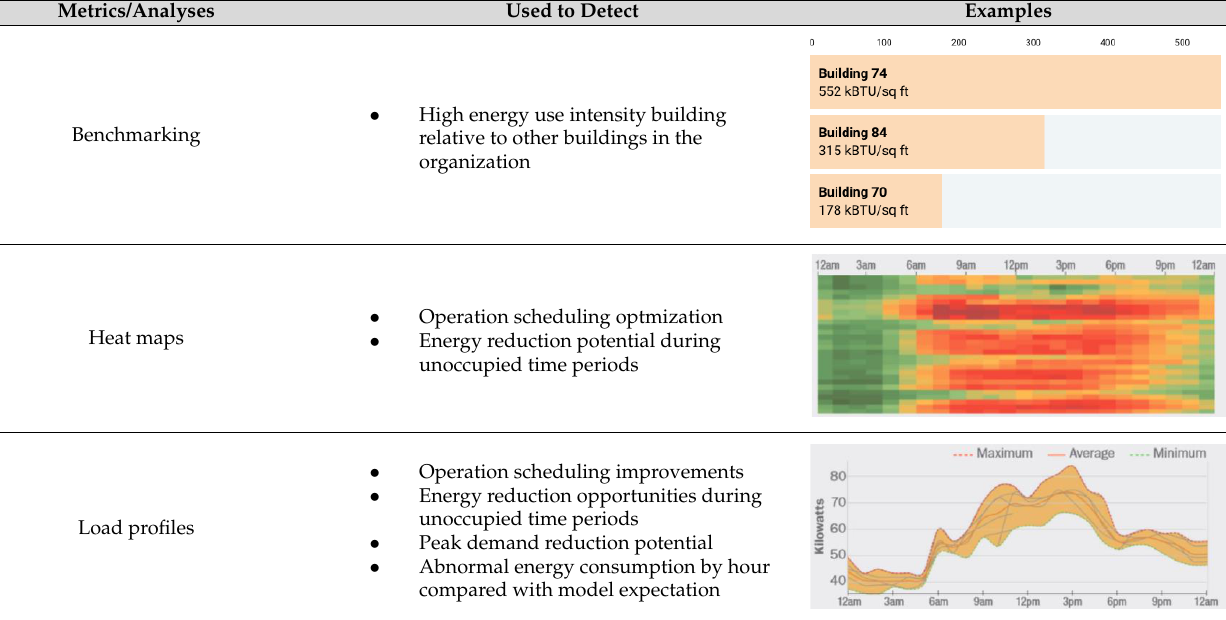
Table 6. Commonly adopted EIS metrics and analyses.